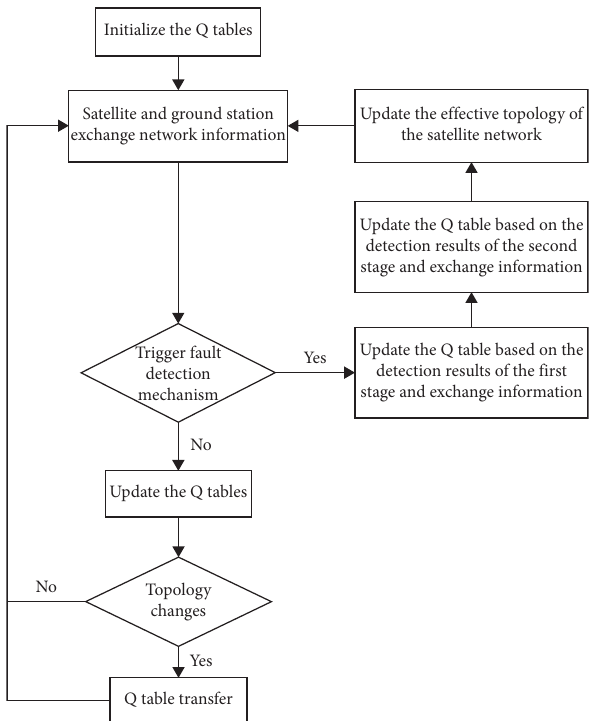
Figure 2: The schematic diagram of route recovery